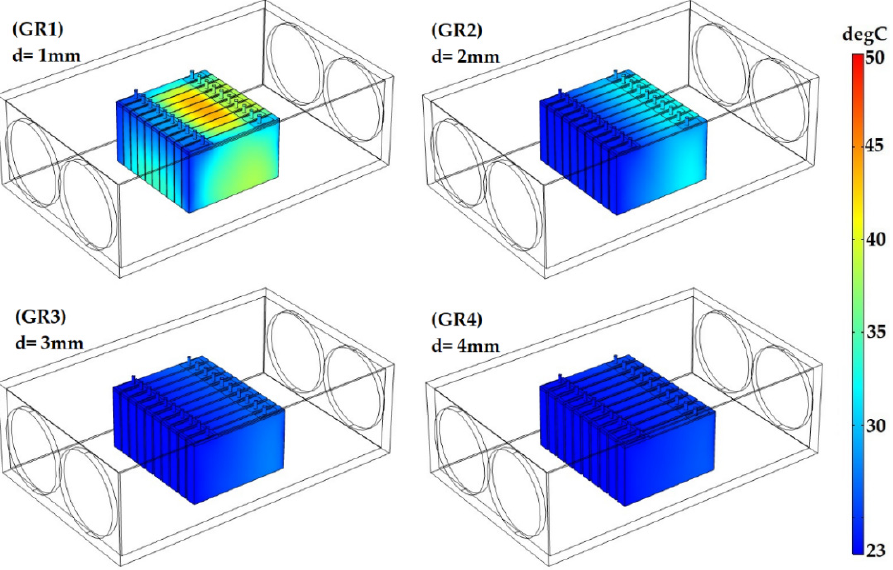
Figure 15. Temperature distribution of the LiC module for the rotated module for various gap spacings between the neighboring LiCs.